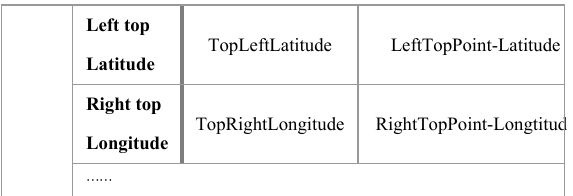
Table2. Examples of product record information